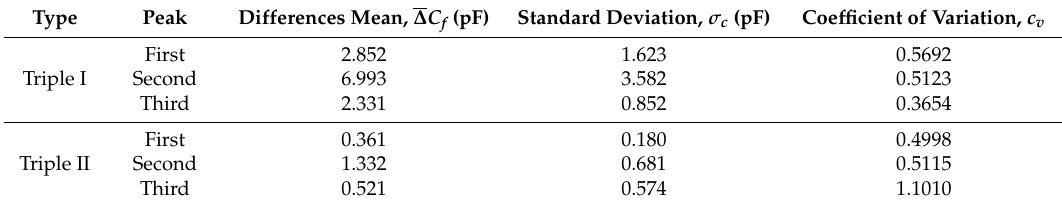
Table 8. Fruitlet capacitance difference evaluation for triple series air coil.